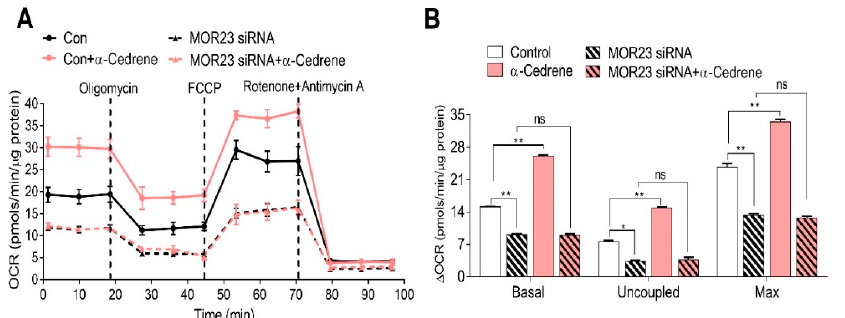
Figure 3. MOR23 depletion decreases thermogenesis and abolishes the thermogenic effect of α -cedrene in 3T3-L1 cells. 3T3-L1 preadipocytes were transfected with MOR23 siRNA, stimulated to differentiate in culture 2 days after transfection in the presence of 100 µ M α -cedrene or 50:50 ( v / v ) DMSO/acetonitrile (vehicle). Oxygen consumption rate measurement was performed after adipocyte induction using the Seahorse XF-24 analyzer. ( A ) Oxygen consumption rate were measured in differentiated 3T3-L1 adipocytes in basal conditions, or in response to sequential treatment with 1 μ M oligomycin (to block ATP synthesis), 1 μ M FCCP (respiratory chain uncoupler), and 0.5 μ M rotenone/antimycin A (inhibitor of respiratory chain complex I and complex III, respectively). ( B ) Δ OCR is calculated by subtracting oxygen consumption rate (OCR) measured after rotenone/antimycin A addition from basal OCR, from OCR after oligomycin addition, or from OCR after FCCP addition. All data are mean ± SEM, n = 3. Significant differences between groups are indicated by asterisks; * p < 0.05; ** p < 0.01; ns, not significant ( p > 0.05).